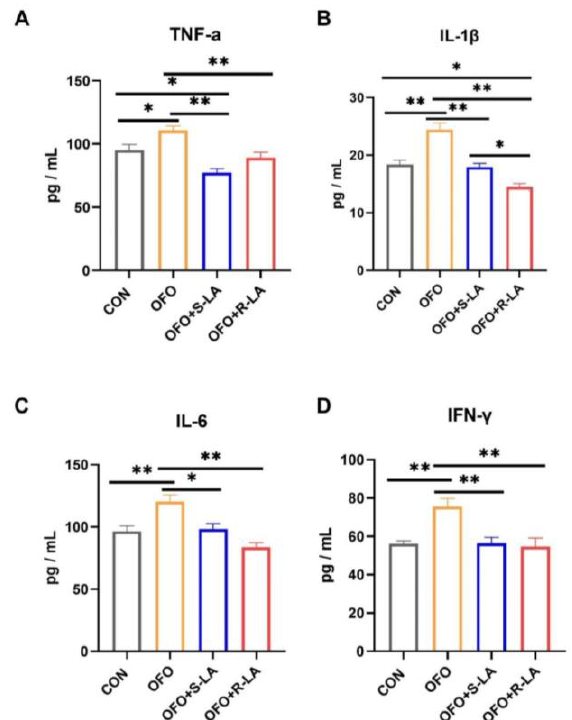
Figure 3. Effect of different treatments on serum inflammatory factors of laying hens. ( A ) Tumor necrosis factor α (TNF- α ); ( B ) interleukin 1 β (IL-1 β ); ( C ) interleukin 6 (IL-6); ( D ) interferon γ (IFN- γ ). * Indicates minimum significant differences ( p < 0.05), and ** indicates highly significant differences ( p <